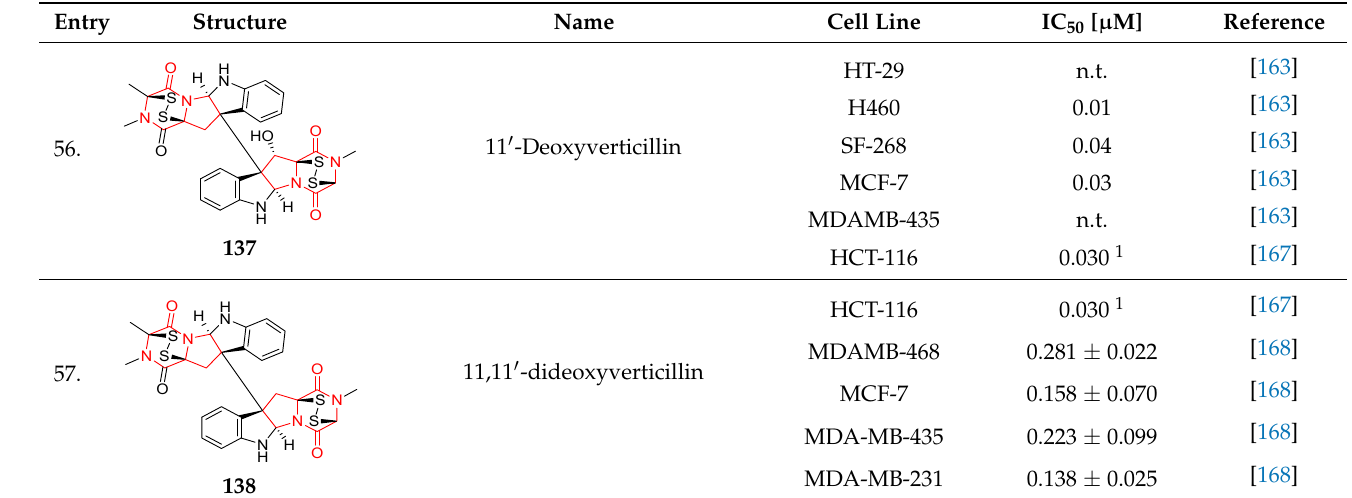
isolated from a Freshwater Delitschia sp. [155] and was evaluated against the African American (Table 6, entry 23). A series of six, pentacyclic, proline ‐ based DKPs, containing disulphide bridge were isolated by Meng from Penicillium brocae MA ‐ 231, an endophytic fungus derived from the marine mangrove plant Avicennia marina [156]. Brocazines A ‐ F ( 106 – 111 ) were evaluated for possible cytotoxic effect using nine cancer cell lines: Du145, HeLa, HepG2, MCF ‐ 7, NCI ‐ H460, SGC ‐ 7901 (gastric cancer), SW1990 (pancreatic adenocarcinoma), SW480 (colon adenocarcinoma), and U251. The authors reported that two compounds, Brocazine C ( 108 ) and Brocazine D ( 109 ), did not exhibit significant cytotoxic activity against the tested cancer cell lines with IC 50 values greater than 20 μ M (Table 6, entries 26, 27). Brocazine A ( 106 ) exhibited the cytotoxic effect in the range of 2.0 (SW480)—6.8 (HeLa) (Table 6, entry 24), Brocazine B ( 107 ) in the range of 1.2 (SW480)—6.4 (SW1990) (Table 6, entry 25), Brocazine E ( 110 ) in the range of 2.1 (SW1990)—12.4 (NCI ‐ H460) (Table 6, entry 28) and Brocazine F ( 111 ) in the range of 0.89 (NCI ‐ H460)—8.0 (SGC ‐ 7901) (Table 6, entry 29). Pentacyclic, proline ‐ based DKPs, possessing disulphide bridge or thiomethoxy groups were isolated by Kong from the marine ‐ derived fungus Phoma sp. OUCMDZ ‐ 1847 [152]. Epicorazine A ( 112 ), Epicorazine B ( 113 ), Epicorazine C ( 114 ), and Exserohilone A ( 115 ) were tested for cytotoxic effect against five cancer cell lines: HL ‐ 60, HCT ‐ 116, A549, K562, and MGC ‐ 803 (Table 6, entries 31–34). The authors found that Epicorazine A ( 112 ) turned out to be the most cytotoxic from the compounds tested with IC 50 values of 0.05 (HL ‐ 60), 0.33 (HCT ‐ 116), 2.3 (A549), 1.5 (K562), and 2.7 μ M (MGC ‐ 803) (Table 6, entry 31), and HL ‐ 60 cell line was the most susceptible from the lines used in the research. Brocazine G ( 116 ), Spirobrocazine A ( 117 ), and Spirobrocazine B ( 118 ) were isolated from the mangrove ‐ derived endophytic fungus Penicillium brocae MA ‐ 231 and tested for cytotoxicity against sensitive and cisplatin ‐ resistant human ovarian cancer cell lines A2780 and A2780 CisR (Table 6, entries 35–37) [157], whereas Spirobrocazine A ( 117 ) and Spirobrocazine B ( 118 ) did not exhibit any activity, Brocazine G ( 116 ) showed strong activity not only to A2780 but also to A2780 CisR cells, with IC 50 values of 0.664 and 0.661 μ M, respectively, stronger than that of cisplatin used as a positive control. 5 ′‐ Hydroxy ‐ 6 ′‐ ene ‐ epicoccin G ( 119 ), 7 ‐ methoxy ‐ 7 ′‐ hydroxyepicoccin G ( 120 ), 8 ′‐ acetoxyepicoccin D ( 121 ), 7 ′‐ demethoxyrostratin C ( 122 ), Epicoccin E ( 123 ), Epicoccin G ( 124 ), and Rostracin C (124) were isolated by Chi from the deep sea ‐ derived fungus Epicoccum nigrum SD ‐ 388 and tested for cytotoxicity against Huh7.5 liver tumor cells (Table 6, entries 38–44) [158]. Compounds 119– 121 , 123 , and 124 turn out to be completely inactive, while 7 ′‐ demethoxyrostratin C ( 122 ) and Rostracin C ( 125 ) showed marked activity with IC 50 values of 9.52 and 4.00 μ M,